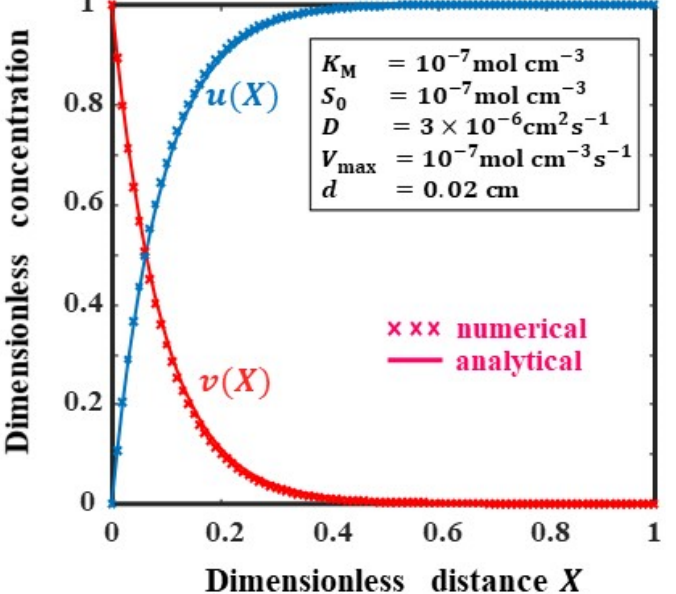
Figure 1. Concentration profile of substrate and product. The solid line represents the analytical results (Equations (16) and (17)) and the dotted line represents the numerical result.